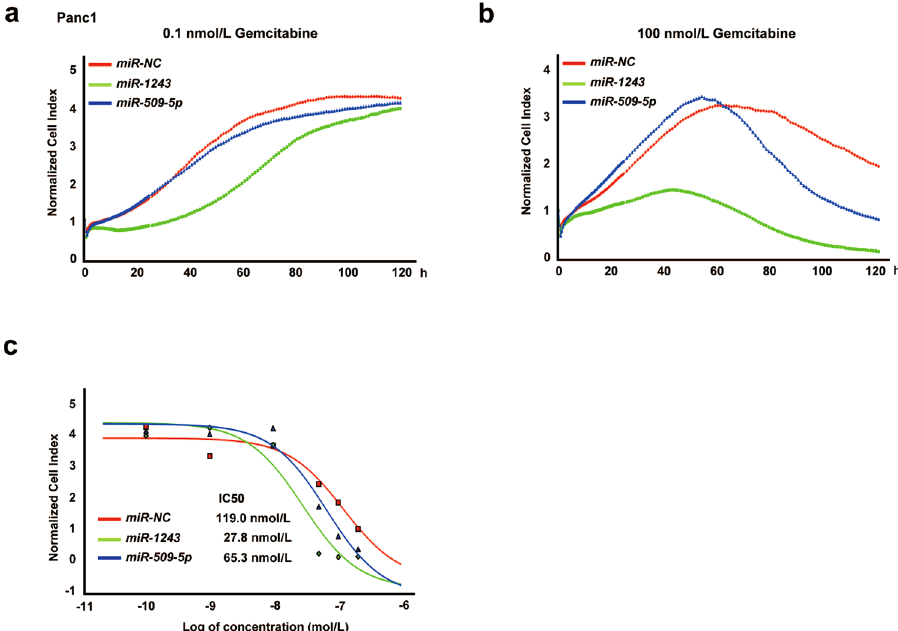
Figure 5. Overexpression of miR-509-5p and miR-1243 enhances the effect of gemcitabine. ( a , b ) Effect of a combination of miRNA and gemcitabine on cell index curves (RTCA) in Panc1 cells. A total of 5 nmo/L of miR-NC , miR-509-5p or miR-1243 was transfected, and cells were treated with gemcitabine (0.1, 1, 10, 50, 100 and 200 nmol/L) after 6 hours. Figure 5a shows 0.1 nmol/L gemcitabine-treated cells, and Fig. 5b shows 100 nmol/L gemcitabine-treated cells. Cell indexes were normalized with the last time point before treatment with gemcitabine. ( c ) Representative curves of the growth-suppressive effects at 120 hours following treatment with gemcitabine in cells transfected with miR-NC , miR-509-5p and miR-1243 , and the IC50 in each miRNA transfectant.